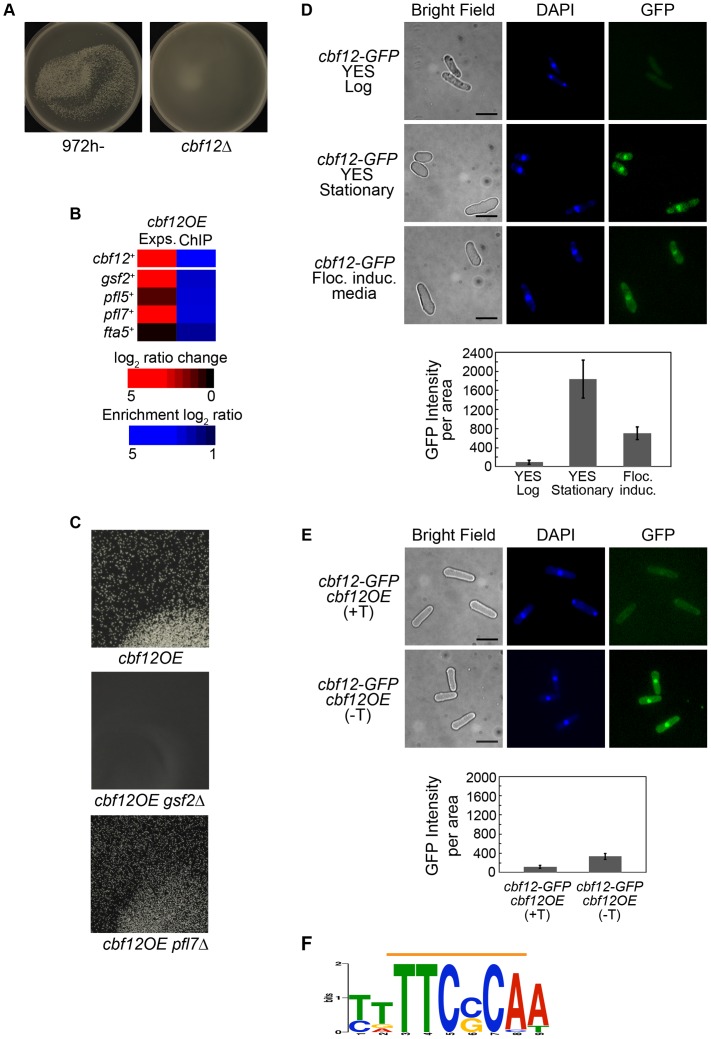
Regulation of flocculation by Cbf12.(A) Loss of cbf12+ prevents flocculation under inducing conditions. Wild type and the cbf12Δ mutant were cultured in flocculation-inducing medium for 5 days at 30°C. (B) Cbf12 regulates putative flocculin genes. The heat map shows induction of several flocculin genes and their promoter occupancy by Cbf12 from microarray expression profiling and ChIP-chip analysis, respectively, of an nmt41-driven cbf12-HA strain. The color bars reflect relative expression and ChIP enrichment ratios between experimental and control. (C) The absence of gsf2+, but not pfl7+ abolishes the flocculation triggered by cbf12+ overexpression. Strains containing nmt1-driven cbf12+ in wild type, gsf2Δ or pfl7Δ backgrounds were cultured for 24 hours in EMM minus thiamine medium at 30°C. Approximately 1/16 of the petri-dish was magnified to reveal more details of the flocs. (D) cbf12+ is expressed in wild-type cells grown in rich medium at stationary phase and in flocculation-inducing medium, but not in rich medium at log phase. A C-terminal GFP-tagged cbf12+ strain under the control of its native promoter was grown to log or stationary phase in YES or in the inducing medium at 30°C. The bar graph compares the mean and standard deviation of cellular Cbf12-GFP signals. (E) Positive autoregulation of cbf12+. Ectopic expression of nmt1-driven cbf12+ results in the upregulation of native-controlled Cbf12-GFP expression in log-phase cells. The bar graph compares the mean and standard deviation of cellular Cbf12-GFP signals between induced and uninduced cbf12OE cells with significant difference of p<0.001 (Welch's two tailed t-test; n = 19, df = 25). (F) A DNA motif closely matching the binding specificity of CSL transcription factors was retrieved from the cbf12OE microarray expression data. The promoter region (1000 base pairs upstream of the start codon) of 11 highly-induced genes encoding for cell surface proteins as identified by the Princeton GO Term Finder was applied to MEME using default settings. The orange line indicates bases that match with the known binding site of CSL transcription factors. Cells were stained with DAPI to visualize nuclei. Scale bar, 10 µm.